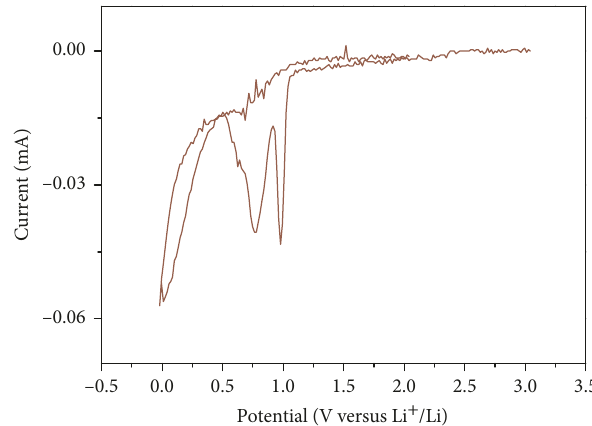
Figure 3: (a) Voltage profiles and (b) cycling performance of NG-7 at various C-rates in 1M 1 . 20mAh g · −